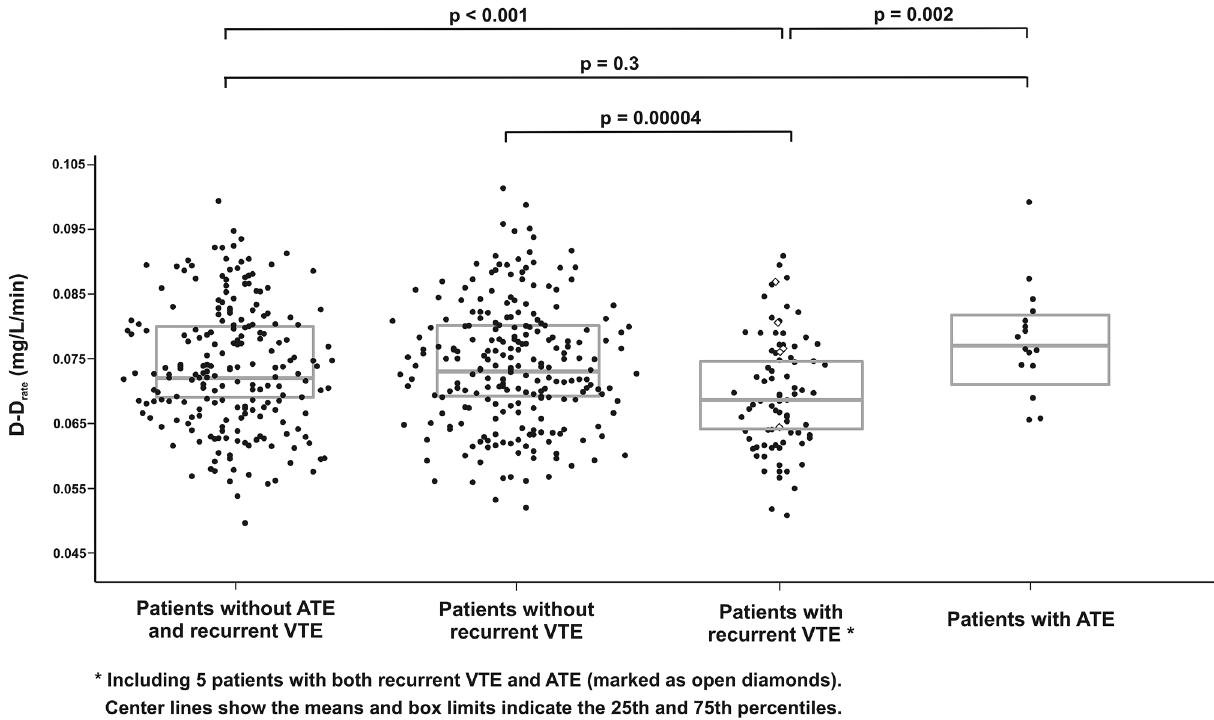
Figure 2. The maximum rate of increase in D-dimer levels (D–D rate ) for patients without both recurrent venous thromboembolism (VTE) and arterial thrombosis event (ATE), patients without recurrent VTE, patients with recurrent VTE and patients with ATE during follow-up.